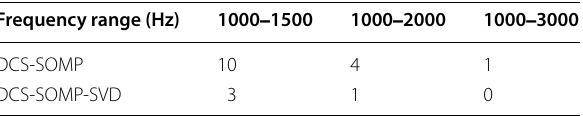
Table 2 The max locating error among whole sources in different frequency ranges